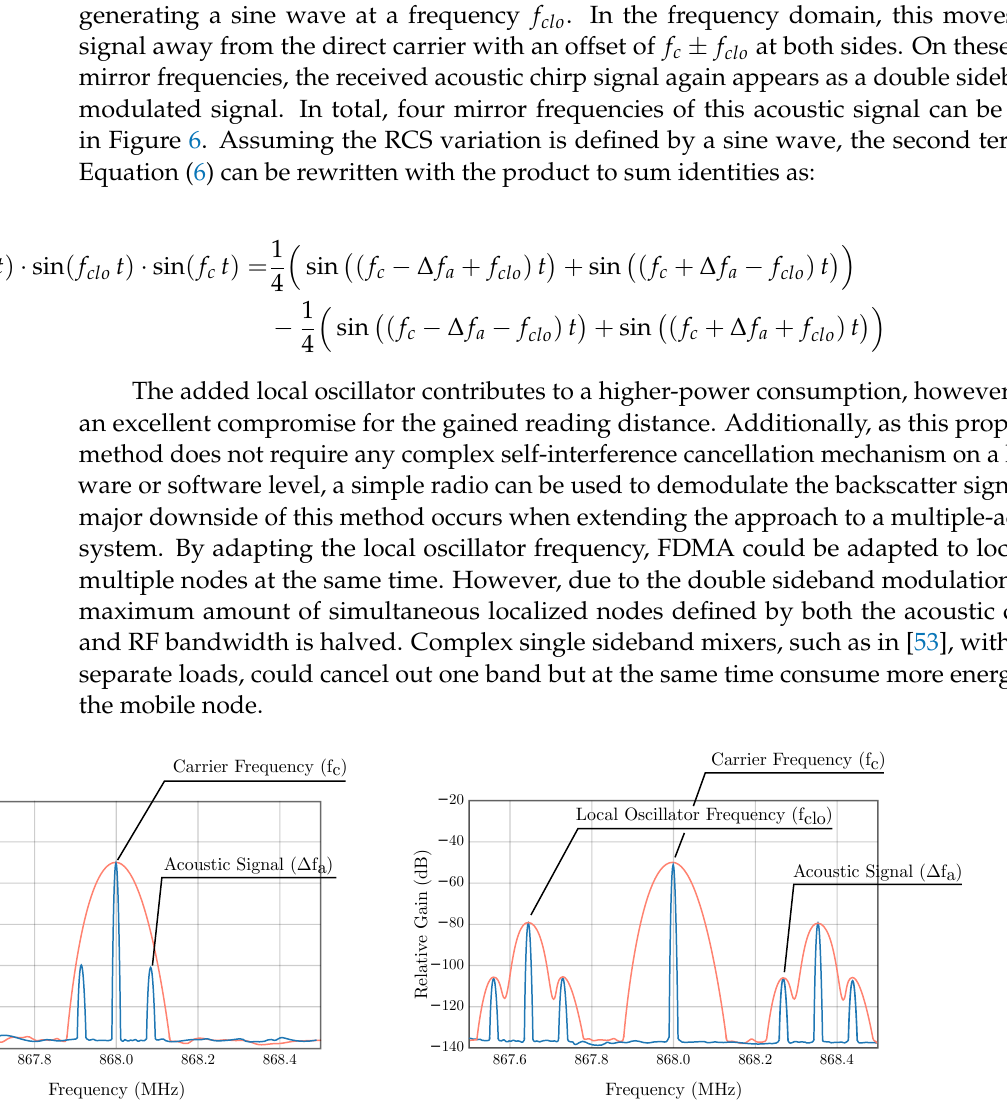
Figure 6. Frequency spectra of the combined direct and backscattered received RF signals without the local oscillator at the backscatter device (left). The blue and orange lines in both figures represent the spectra for, respectively, a small and a large resolution bandwidth. By adding the local oscillator, the backscattered signals were shifted away from the carrier, improving distinctiveness and enabling reception at lower spectral